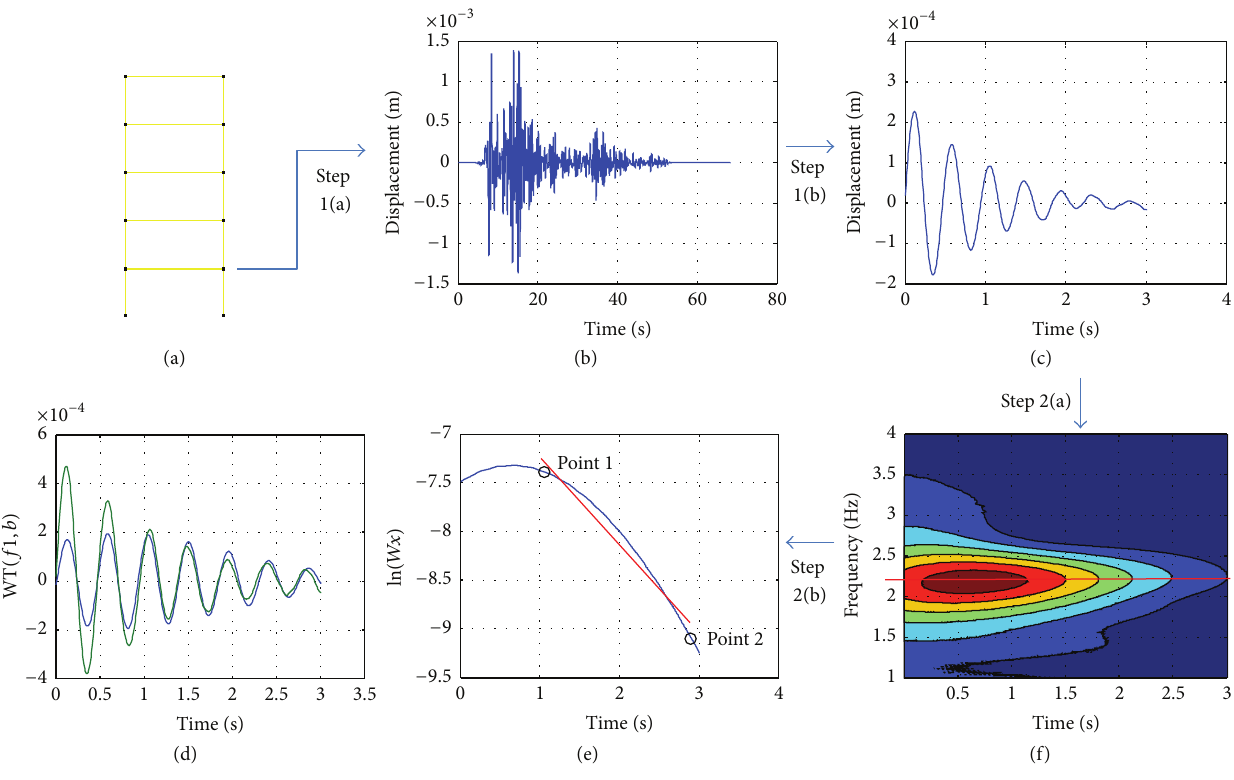
Figure 5: The two-step procedure for estimation of damping ratio.